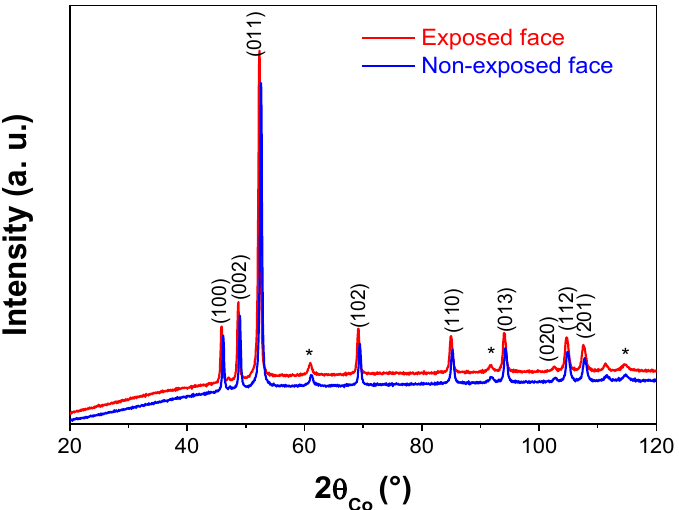
Figure 2. Experimental XRD patterns recorded on the directly exposed (red line) and non-exposed (blue line) to plasma implantation Ni pellet, within grazing conditions. Both were successfully indexed within the hexagonal Ni 2 H structure (ICDD n° 98-020-1088). The small peaks marked by an asterisk correspond to the diffraction planes of the cubic Ni structure (ICDD n° 98-004-3397).